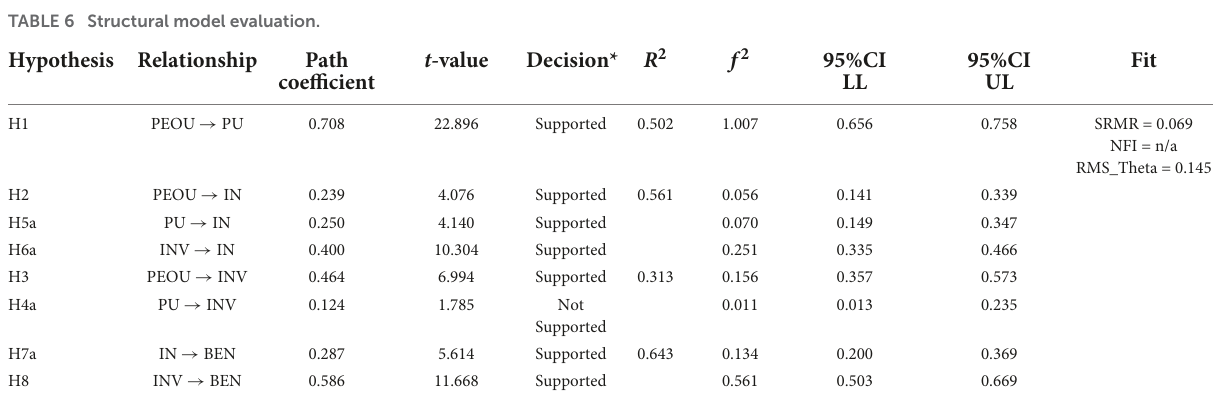
FIGURE2 Structural model analysis results.